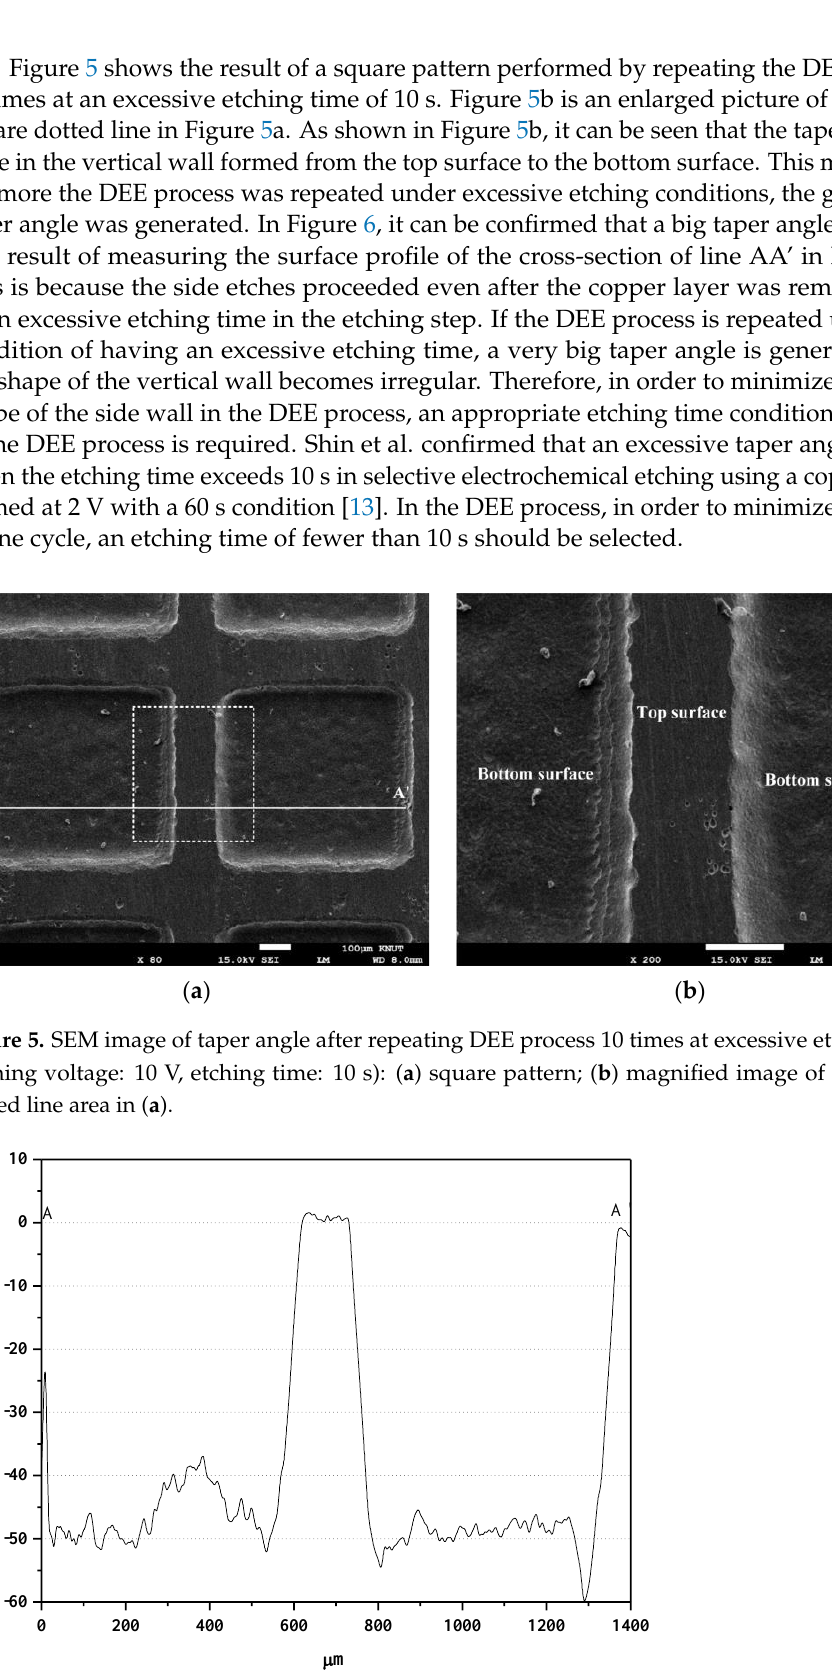
Figure 4. Shape evolution and etch factor in electrochemical etching.